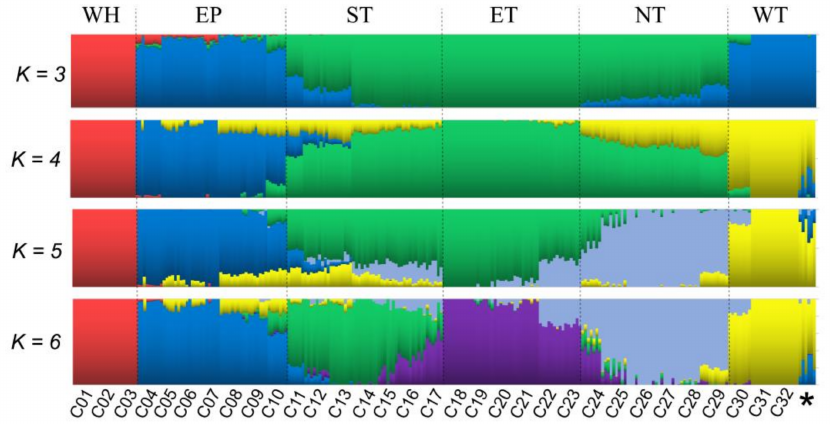
Figure 3. Population genetic structure of C. spinosa according to posterior probabilities assigned to the Bayesian clusters in the ADMIXTURE analysis. The patterns are shown with different K values ( K = 3–6). The six groups are delimited by gray lines. Group WH, western Himalayas; group EP, eastern Pamirs; group ST, the southern piedmont of Tianshan; group NT, the northern piedmont of Tianshan; group ET, eastern Tianshan; group WT, western Tianshan. * , K02 (Almaty population), K01 (Bishkek population), U01 (Osh population), U02 (Batken population), T01 (Nurek